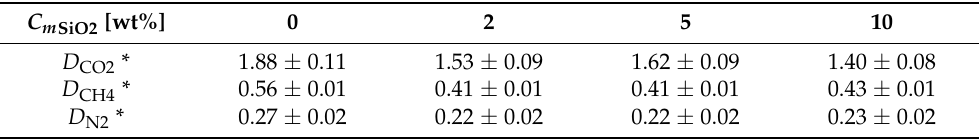
Table A8. Diffusion coefficient D i for membranes of different SiO 2 concentrations. * The values in table should be multiplied.